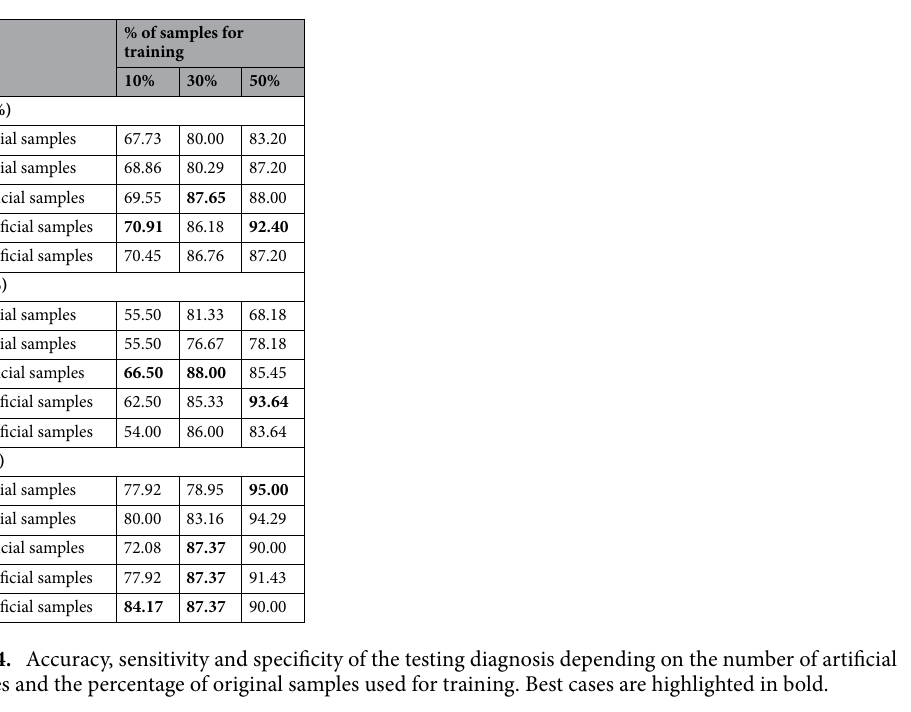
Figure 7. Accuracy (%) of the testing diagnosis depending on the number of artificial samples and the percentage of original samples used for training. Each group of 5 bars correspond to a different percentage of original samples used for training. The number of artificial samples in each case is represented by the different colours of the bars. The best and the second-best cases are indicated with the corresponding value of accuracy.